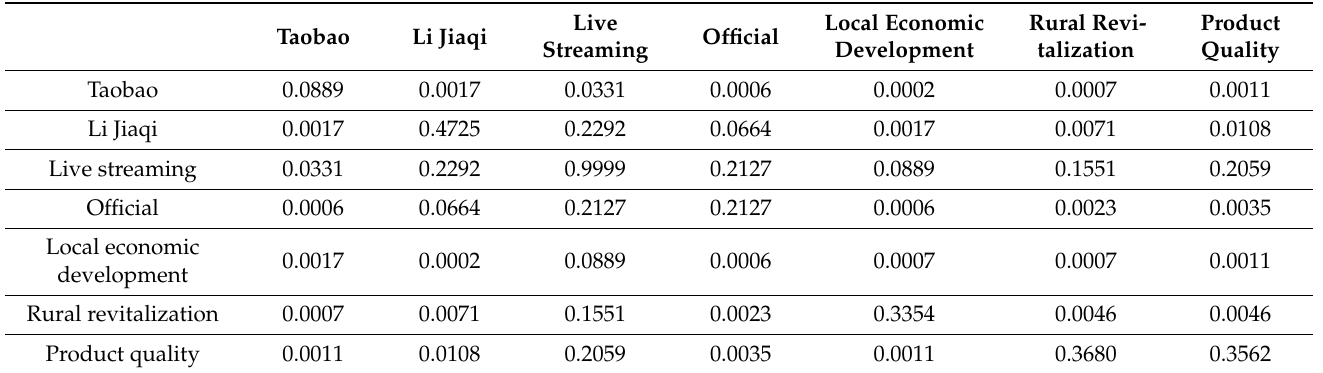
Table 4. Co-occurrence matrix of subject